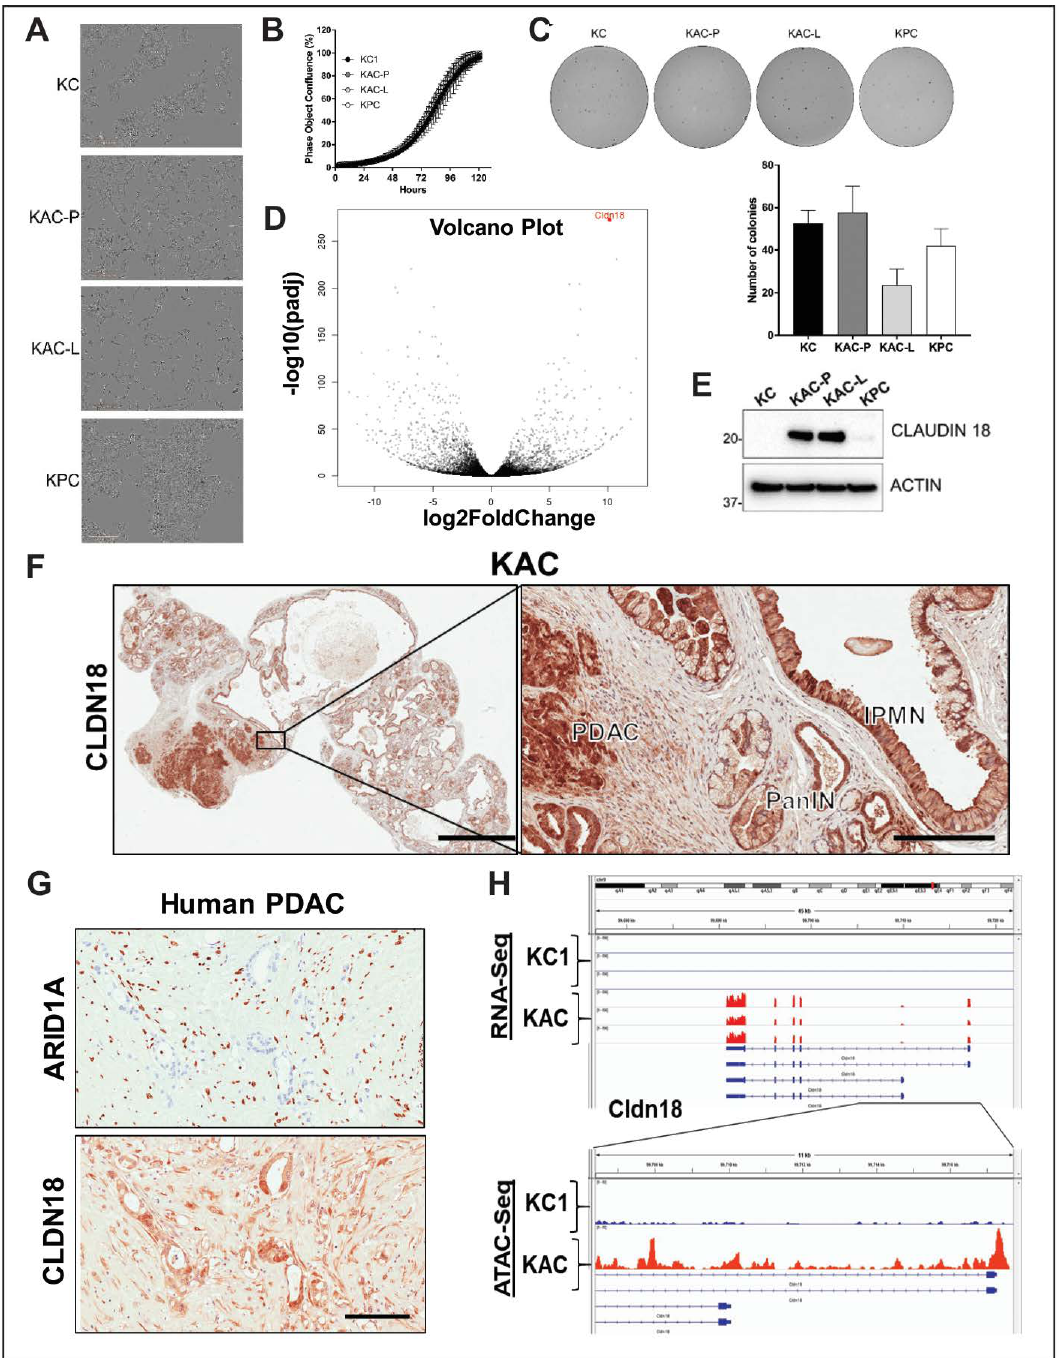
Figure 4. Characterization of autochthonous Arid1a -null PDAC cells from “KAC” mice. ( A ) In vitro monolayer cultures of “KC”, “KAC-P”, “KAC-L” and “KPC” cells revealed mesenchymal-like elongated morphology of “KAC” cells. Scale bar, 50 µ m. ( B , C ) Assessment of growth in both monolayer ( B ) as well as soft-agar ( C ) showed no significant di ff erence between “KAC” cells when compared to “KC” and “KPC”. Representative images of crystal violet stained colonies from 3 independent experiments. ( D ) Volcano plot of di ff erentially expressed genes in “KAC-P” and “KC” cells, using RNA-Seq, showed Claudin 18 (CLDN18) as one of the top hit ( n = 3). ( E ) Immunoblotting for mouse CLDN18 confirmed high expression levels in “KAC” PDAC cells compared to “KC” and “KPC”. Detailed information can be found at Figure S10. ( F ) IHC on pancreatic sections from “KAC” mice showed strong expression in epithelium of IPMN, PanIN, and PDAC, correlative with lack of ARID1A expression. Left ,